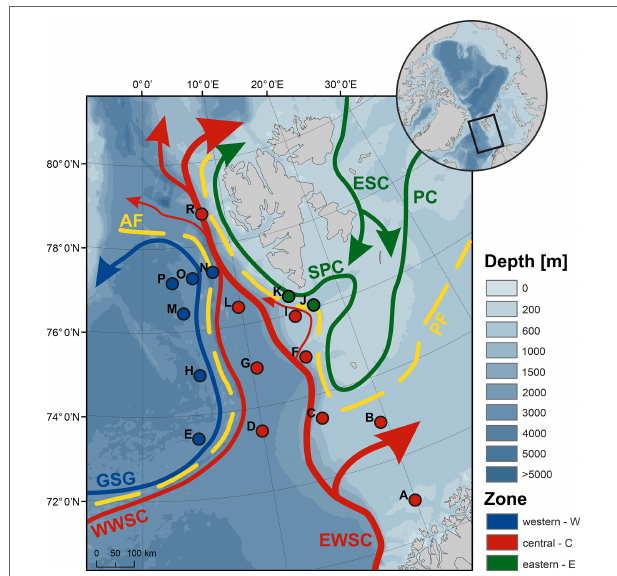
FIGURE 1 | Location of sampling sites (A to R) with a general circulation pattern (ESC, East Spitsbergen Current; EWSC and WWSC, east and west branch of the West Spitsbergen Current; GSG, Greenland Sea Gyre; PC, Persey Current and SPC, Spitsbergen Polar Current), and with the two oceanic fronts (AF, Arctic Front and PF, Polar Front) marked in yellow. Both the oceanic currents and sites are colored according to the frontal zone classification (western W, blue; central C, red and eastern E, green), which, in the case of sites, reflects their prevailing classification (>70% of years falling within a given zone). Bathymetry data were derived from the International Bathymetric Chart of the Arctic Ocean (Jakobsson et al., 2012), while ocean currents were mapped after Beszczynska-Möller et al. (2012) and Lien et al. (2017). Inset map depicts the Arctic Ocean with the investigated area bordered by the black